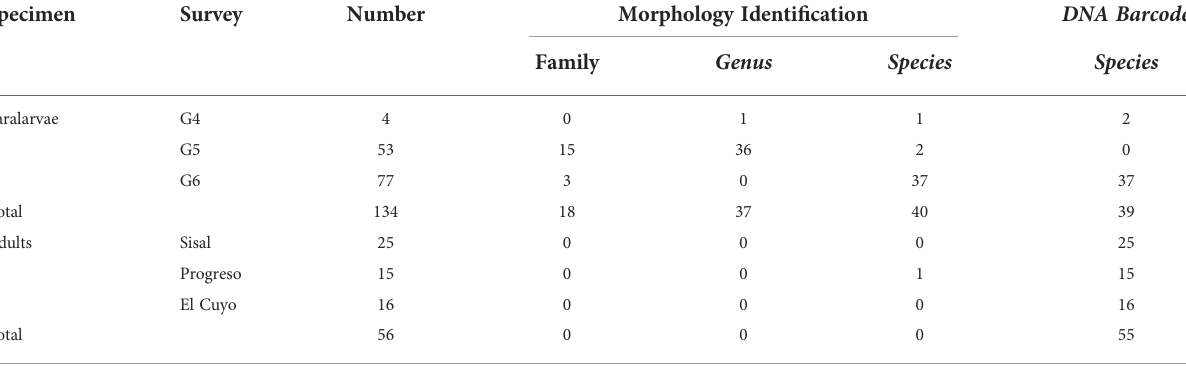
TABLE 1 Number of paralarvae and adults of loliginids from the southeastern Gulf of Mexico (SGoM) and level of identi fi cation by morphological and DNA barcoding approach.